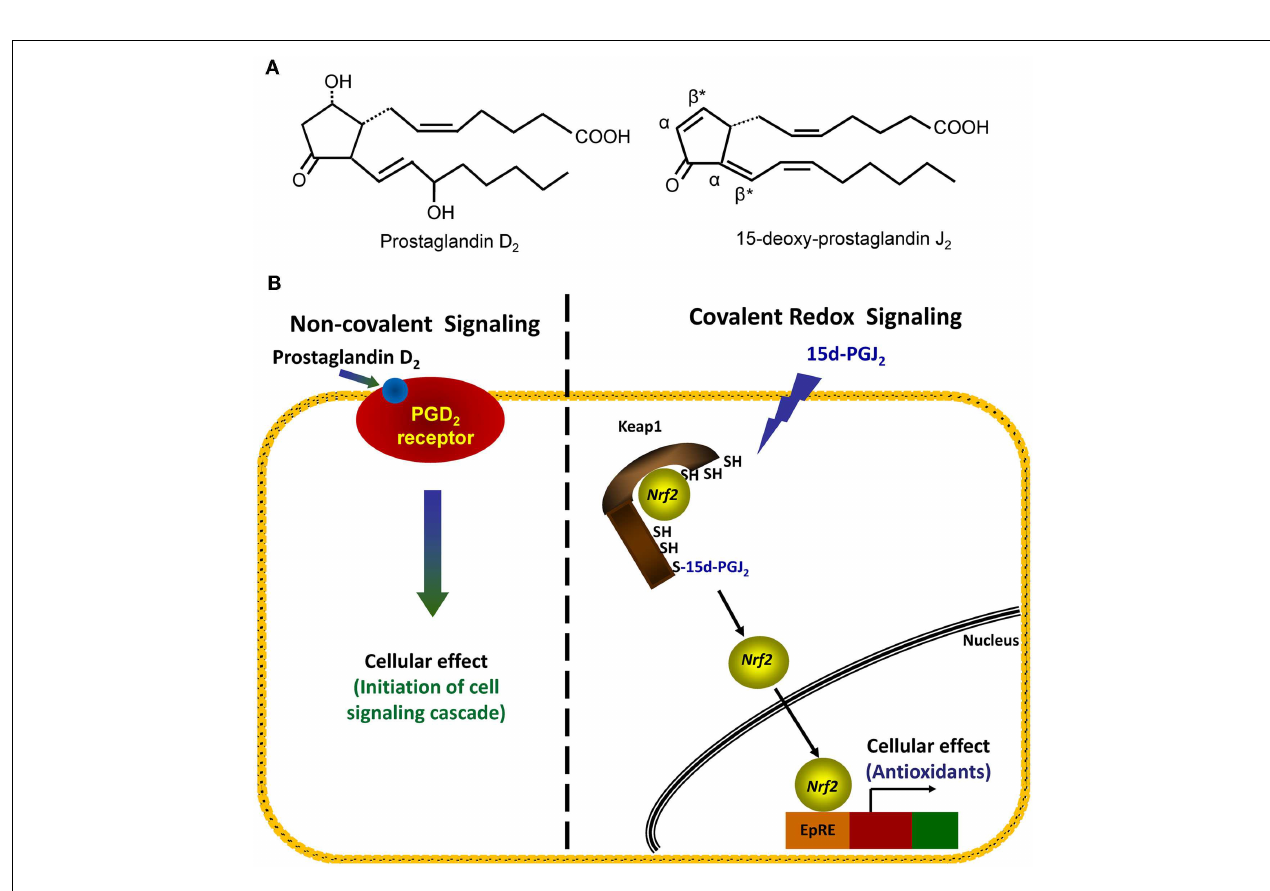
by a specific receptor on the cell membrane.The binding event causes the activation of a signaling cascade which ultimately changes cellular function. Right hand panel: in the covalent signaling model, a reactive species 15d-PGJ 2 directly forms a covalent adduct with select proteins, in this case, the cytosolic repressor protein Keap1. This binding event causes changes in endogenous antioxidant protein transcription via the transcription factor